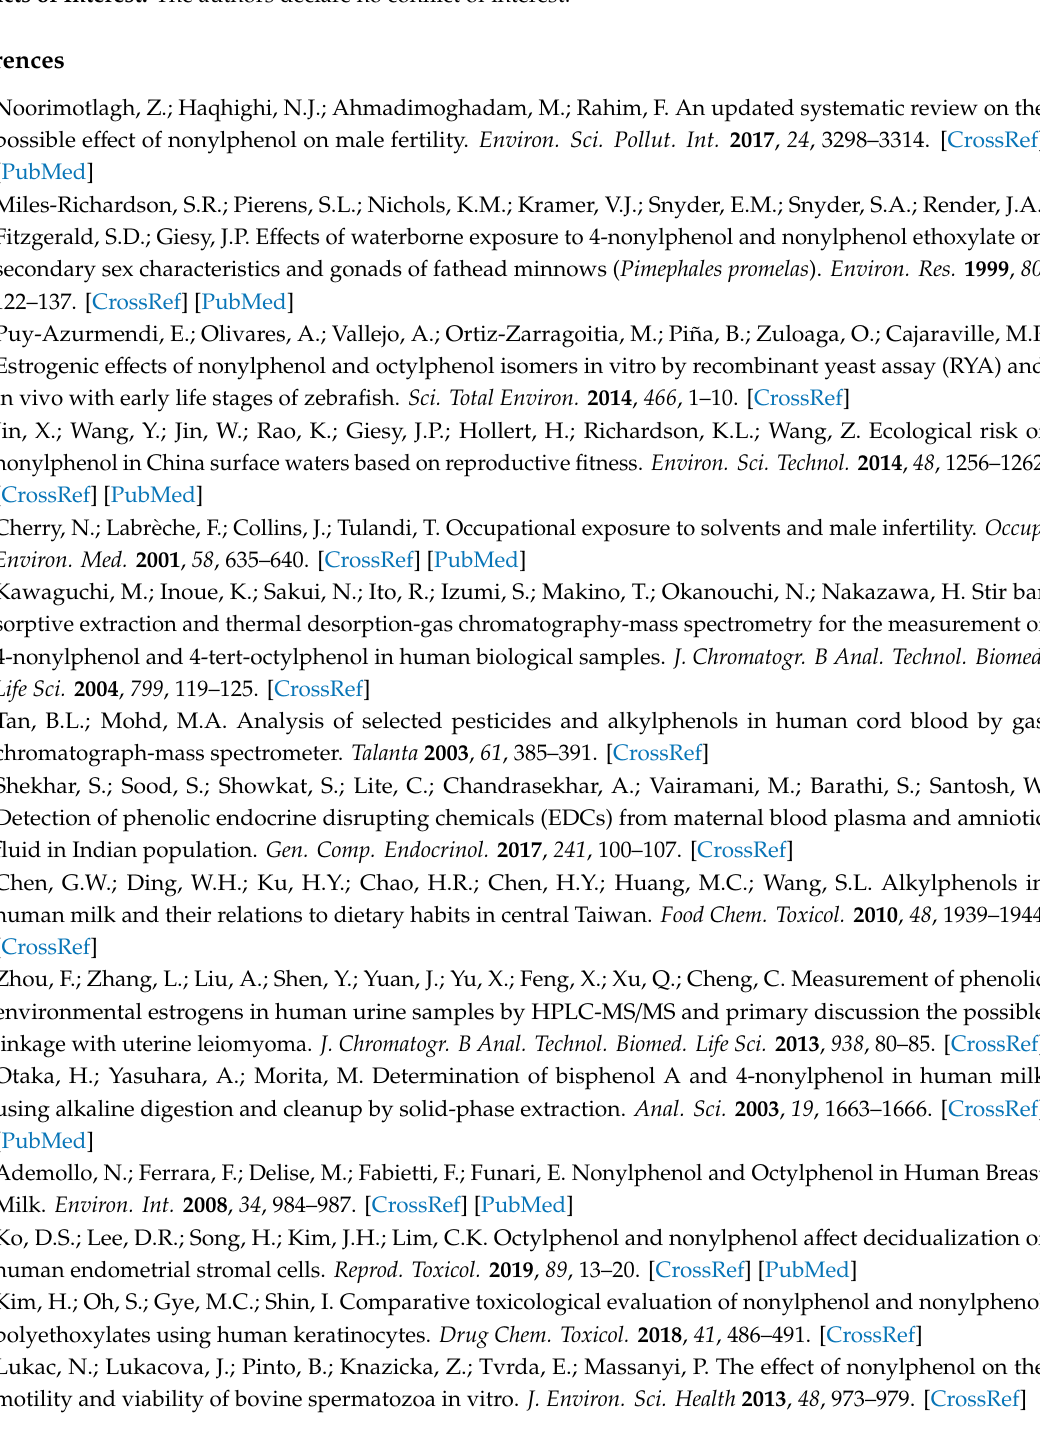
Figure S1: The gene expression of ROS, apoptotic and sertoli cell